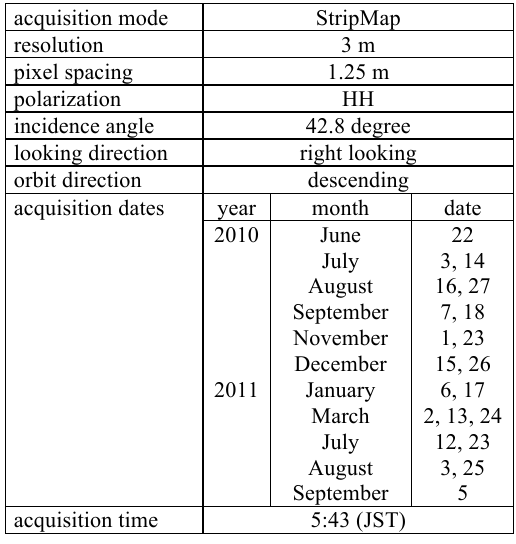
Table 1. Acquisition parameters of utilized 21 TerraSAR-X